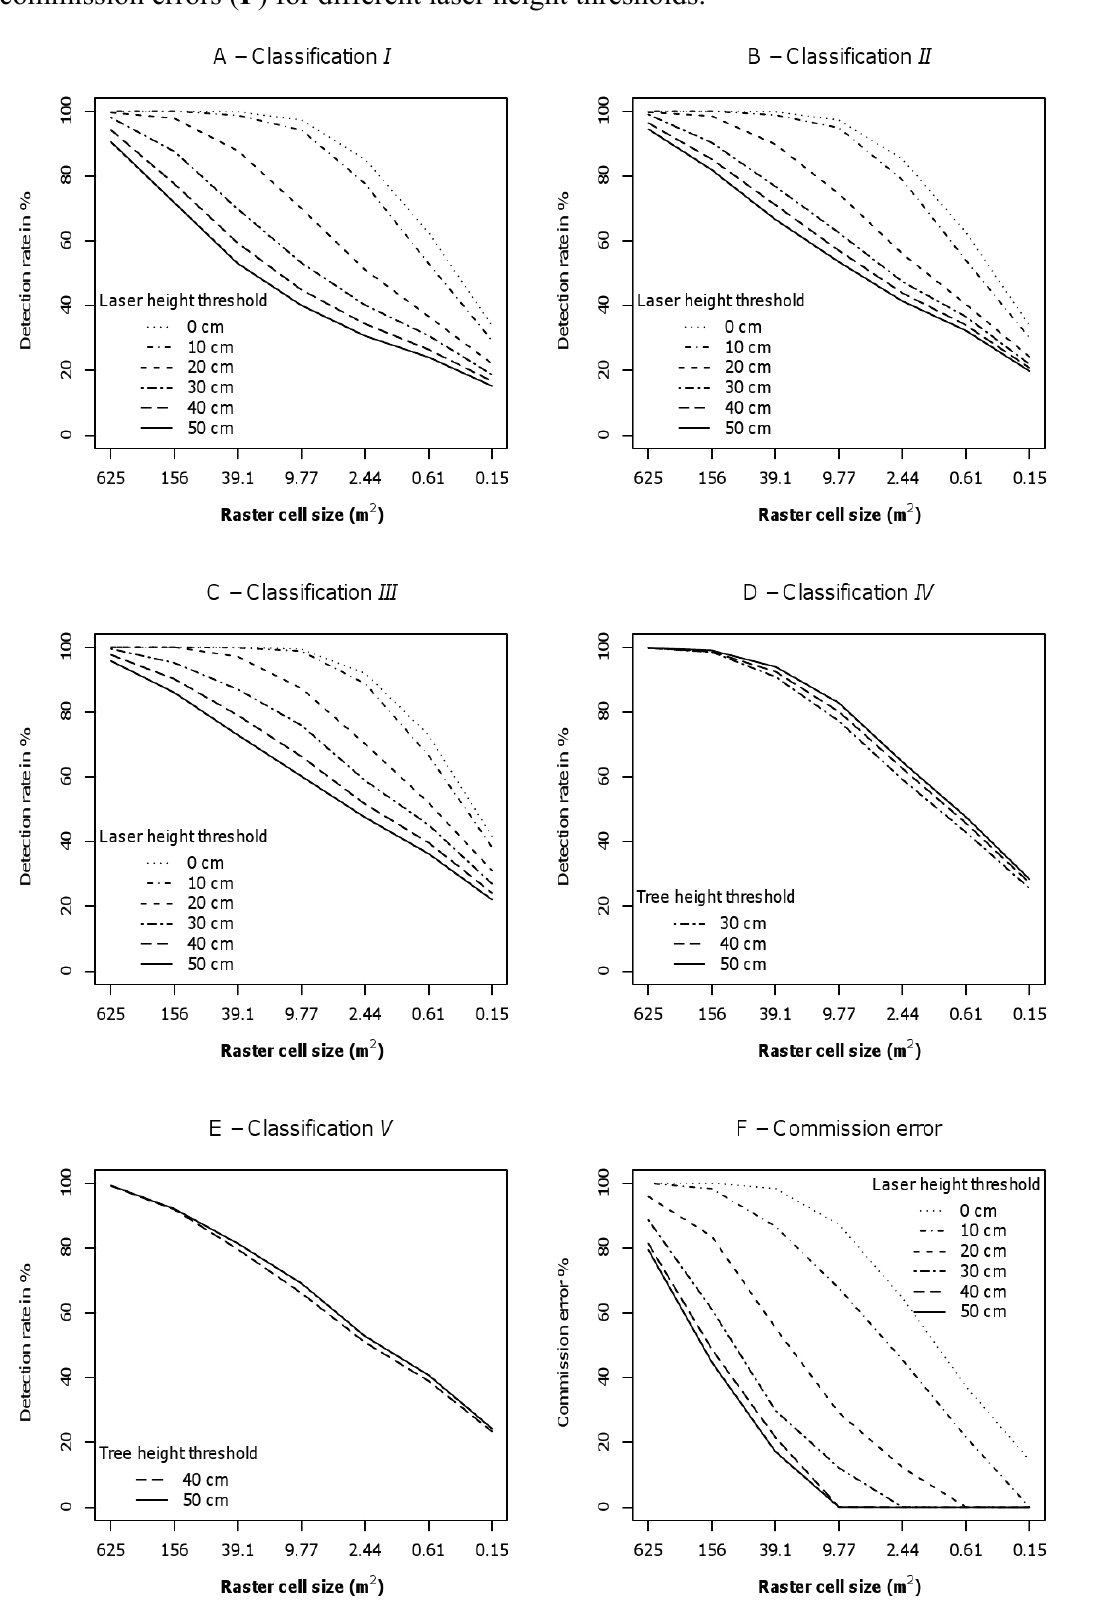
Figure 5. Detection rate for different raster cell sizes for classification I – V ( A – E ) and commission errors ( F ) for different laser height